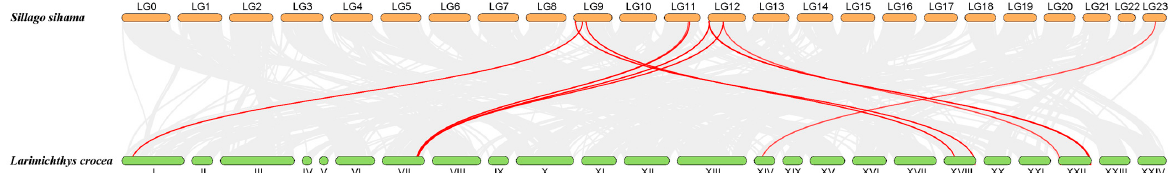
Figure 4. Chromosomal distribution of S. sihama OR genes. The majority of S. sihama OR genes were organized in seven clusters on four chromosomes. The other four OR genes were located on four chromosomes. The genes highlighted in red are expanded genes.